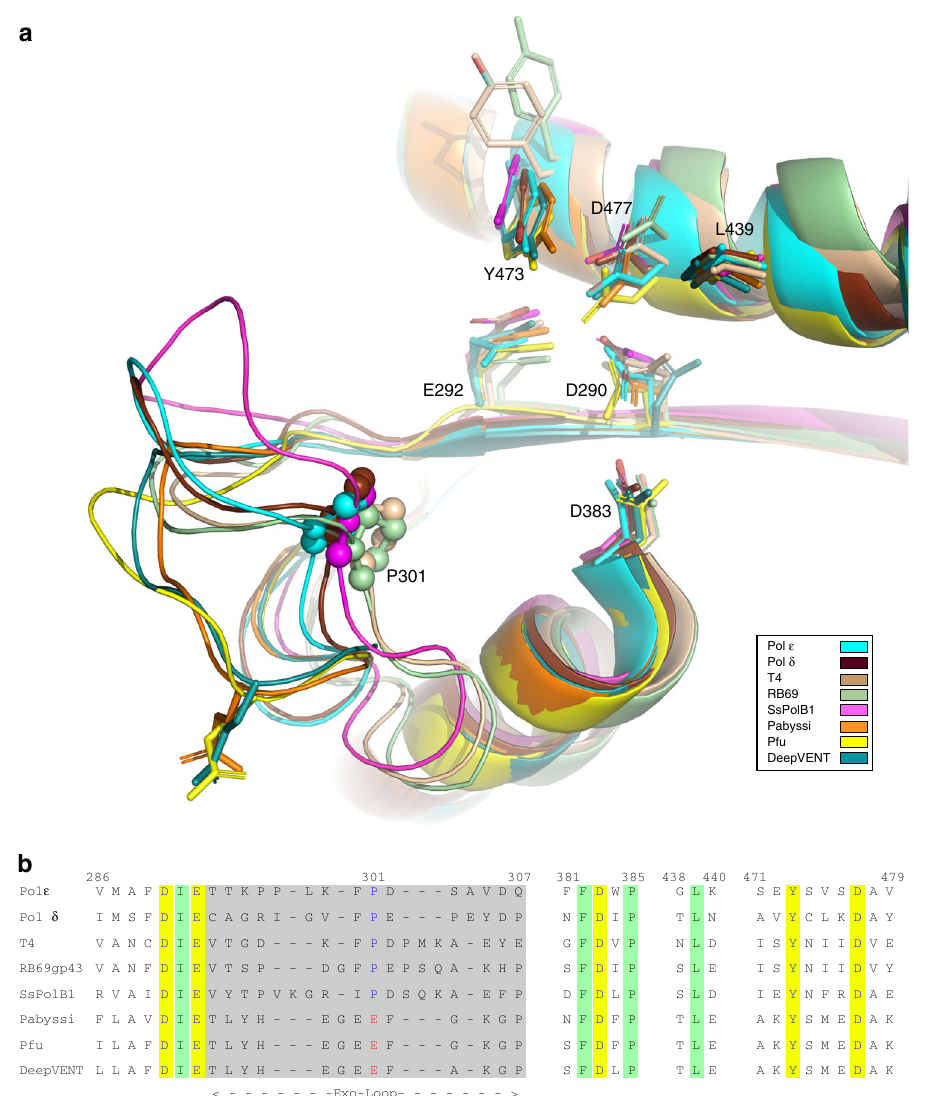
Fig. 3 Structural superimposition and sequence alignment of exonuclease domains from family B polymerases. a Superimposition of the structures of RB69 gp43 (1clq [https://www.rcsb.org/structure/1clq] 22 , pale green), T4 DNA polymerase (1noy [https://www.rcsb.org/structure/1noy] 38 , wheat), S. cerevisiae Pol2 S. cerevisae Pol δ (3iay [https://www.rcsb.org/structure/3iay] 36 , CORE (6fwk [https://www.rcsb.org/structure/6fwk] from this study, cyan), chocolate), Deep VENT (5h12 [https://www.rcsb.org/structure/5h12] 35 , dark cyan), S. solfataricus PolB1 (1s5j [https://www.rcsb.org/structure/1s5j] 34 , magenta), P. furiosus DNA polymerase (2jgu [https://www.rcsb.org/structure/2jgu] 31 , yellow) and P. abyssi DNA polymerase (4 fl w [https://www.rcsb. org/structure/4 fl w] 37 , orange). b Structure based sequence alignment. Residues involved in the catalytic activity are shown in yellow background. The length of the Exo-loop is marked with arrows. P301 is in blue font, and the corresponding glutamic acid is in red. Other conserved residues are in pale green